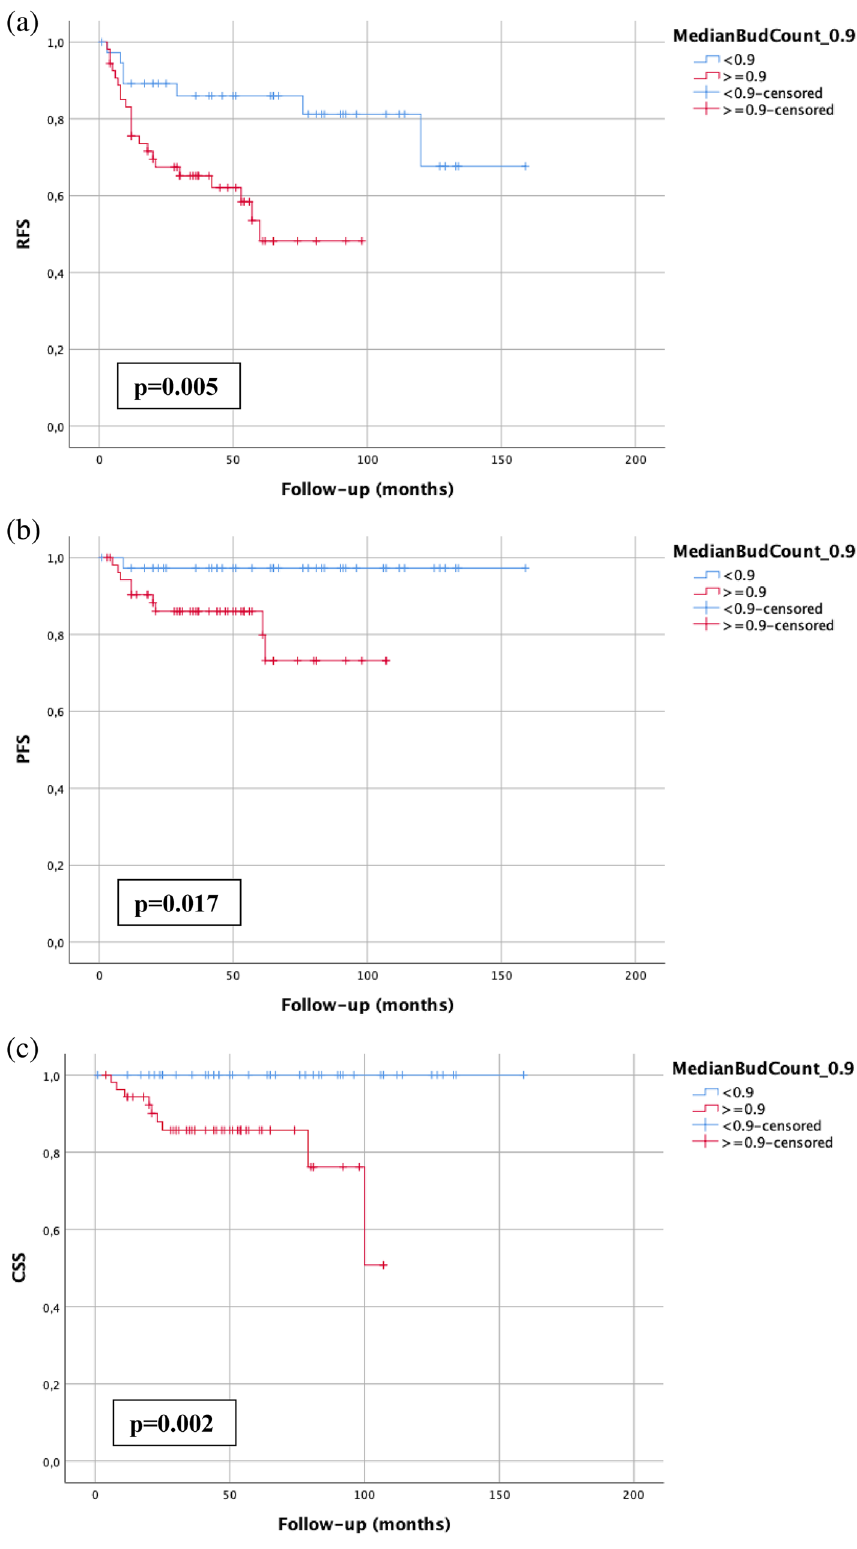
Figure 2. Kaplan–Meier analysis of tumor budding (cutoff: 0.9) in the total pT1 NMIBC cohort with the bladder-sparing approach (n = 92) regarding RFS ( a ), PFS ( b ) and CSS ( c ). A p value < 0.05 indicates significant